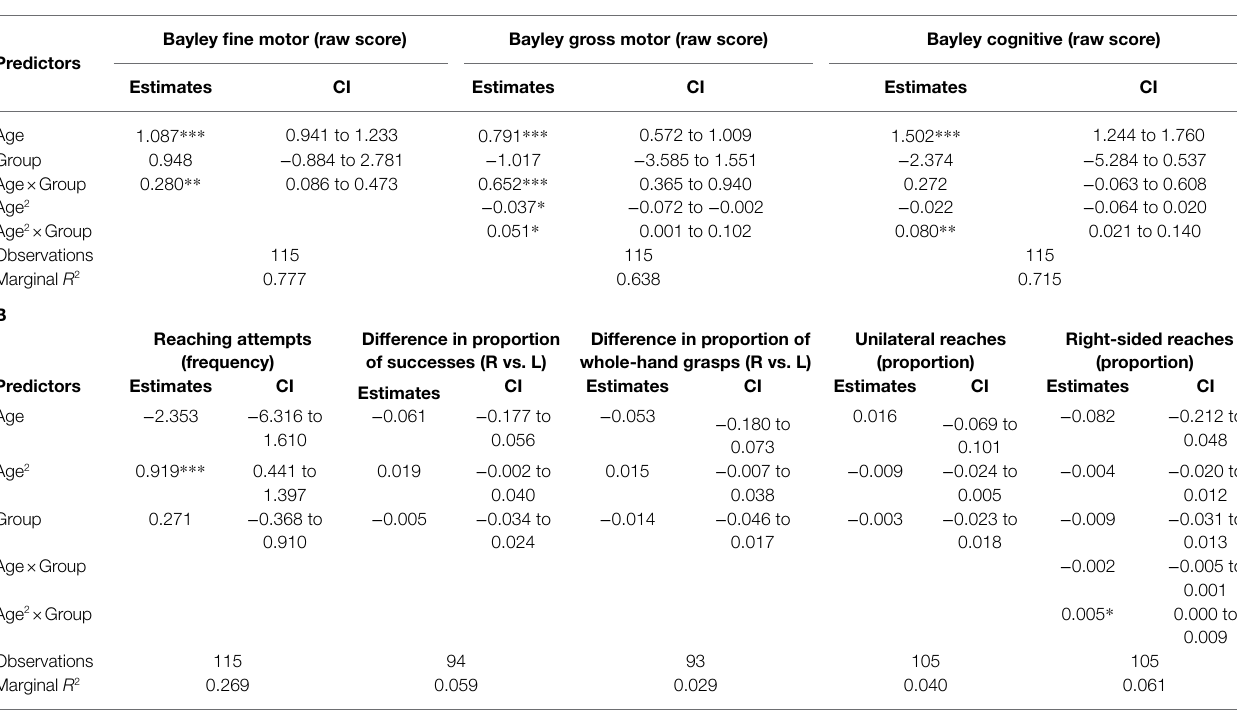
Non-significant interactions and polynomial terms were excluded from the final model. 95% confidence intervals for parameter estimates are displayed. Results are from 32 participants across 115 visits. * p < 0.05. ** p < 0.01. *** p < 0.001.